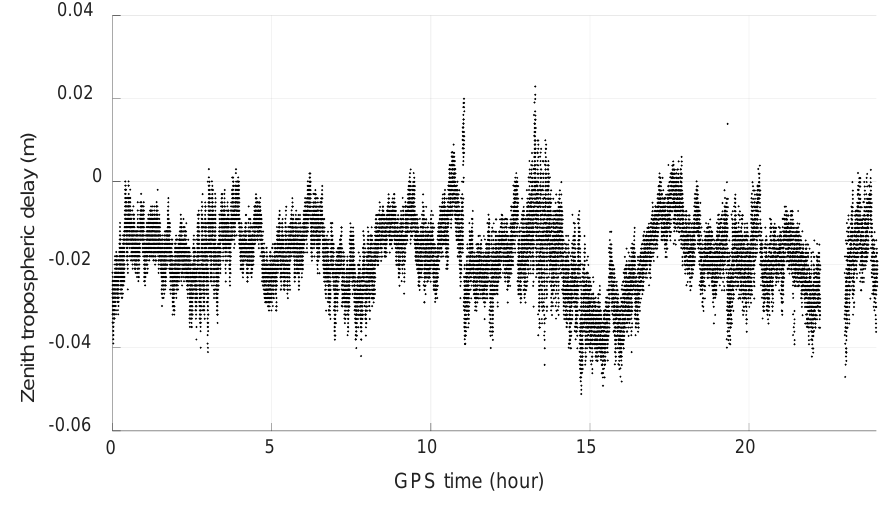
Figure 4. Estimated zenith tropospheric delay (BDS).